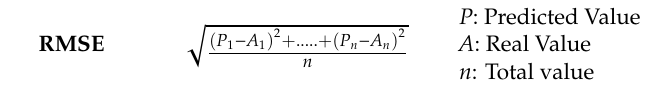
Table 6. Error Analysis, Formula and Parameters.